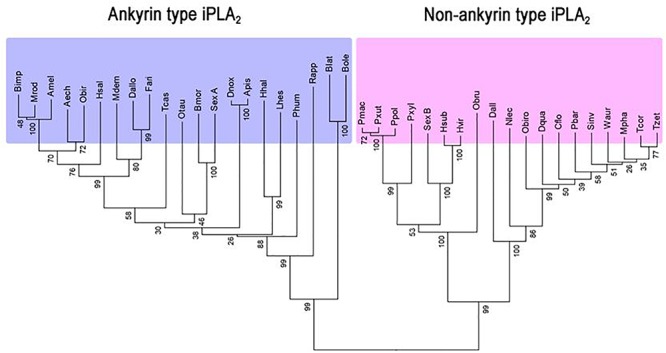
Two groups of insect iPLA2s. Phylogenetic analysis was performed by the Neighbor-joining method using the software package MEGA 6.0. Bootstrap values (expressed as percentage of 1,000 replications) are shown next to the branches. Amino acid sequences were retrieved from GenBank with accession numbers: XP_011063787.1 for Acromyrmex echinatior (Aech), XP_006565723 for Apis mellifera (Amel), XP_001944054.1 for Acyrthosiphon pisum (Apis), XP_004931589.1 for Bombyx mori (Bmor), JAI19791.1 for Bactrocera latifrons (Blat), XP_014090410.1 for Bactrocera oleae (Bole), XP_003492592.1 for Bombus impatiens (Bimp), XP_011261757.1 for Camponotus floridanus (Cflo), XP_015115454.1 for Diachasma alloeum (Dall), XP_015122829.1 for Diachasma alloeum (Dallo), XP_014488689.1 for Dinoponera quadriceps (Dqua), XP_015368613.1 for Diuraphis noxia (Dnox), JAG76826.1 for Fopius arisanus (Fari), XP_014284806.1 for Halyomorpha halys (Hhal), XP_011144133 for Harpegnathos saltator (Hsal), AGG55019.1 for Heliothis subflexa (Hsub), AGG55005.1 for Heliothis virescens (Hvir), JAQ13976.1 for Lygus hesperus (Lhes), XP_003702751.1 for Megachile rotundata (Mrod), XP_008559240.1 for Microplitis demolitor (Mdem), XP_012538958.1 for Monomorium pharaonis (Mpha), XP_015521797.1 for Neodiprion lecontei (Nlec), XP_022912622.1 for Onthophagus taurus (Otau), XP_011347626.1 for Ooceraea biroi (Obir), XP_011340273.1 for Ooceraea biroi (Obiro), KOB75232.1 for Operophtera brumata (Obru), XP_013147925.1 for Papilio polytes (Ppol), XP_014361526.1 for Papilio machaon (Pmac), XP_002432031.1 for Pediculus humanus corporis (Phum), XP_011641703.1 for Pogonomyrmex barbatus (Pbar), XP_013165315.1 for Papilio xuthus (Pxut), XP_011550190.1 for Plutella xylostella (Pxyl), JAP82800.1 for Rhipicephalus appendiculatus (Rapp), XP_011170109.1 for Solenopsis invicta (Sinv), XP_018367102.1 for Trachymyrmex cornetzi (Tcor), XP_018301493.1 for Trachymyrmex zeteki (Tzet), XP_971204.1 for Tribolium castaneum (Tcas), XP_011693263.1 for Wasmannia auropunctata (Waur), AIN39484.1 for Spodoptera exigua A (SexA), and AQW44791.1 for Spodoptera exigua B (SexB).